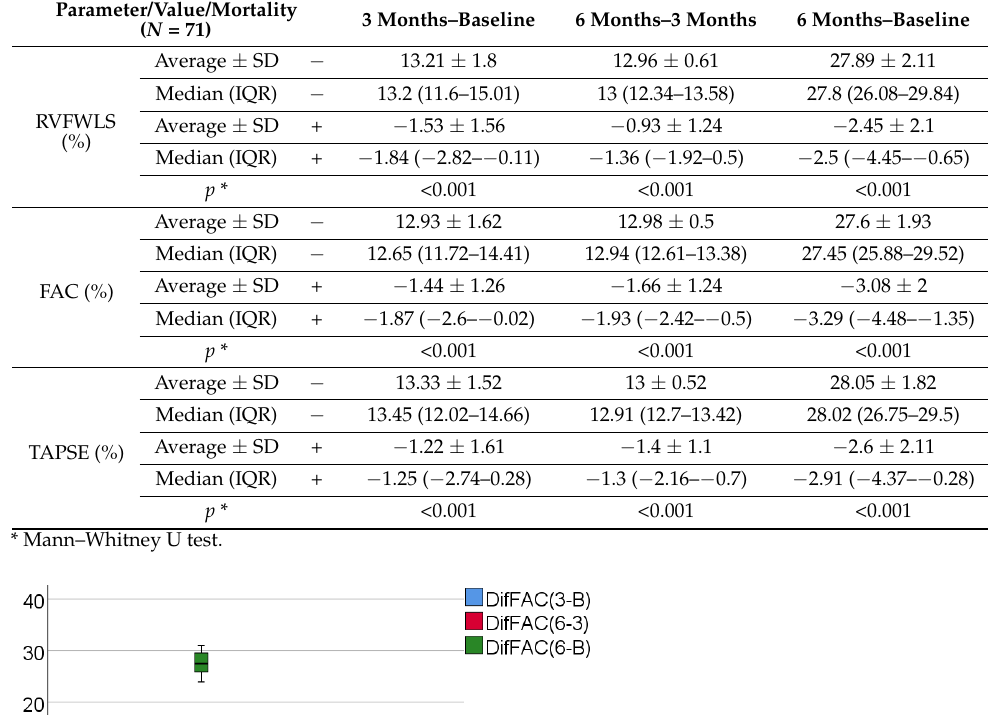
Table 3. Comparison of RVFWLS, FAC, and TAPSE evolution values in comparison to mortality.